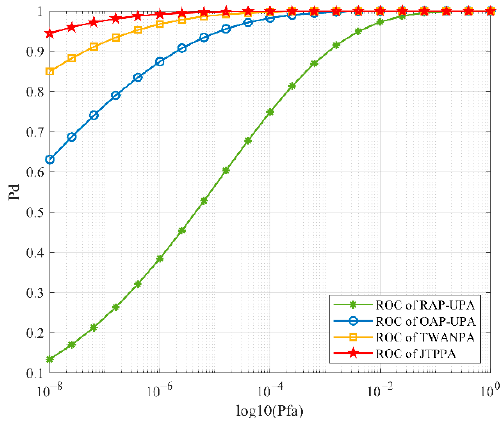
Figure 12. Average ROC curves for five power allocation methods.